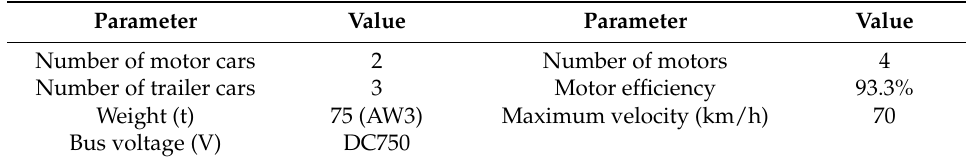
Table 1. Parameters of tram and line.